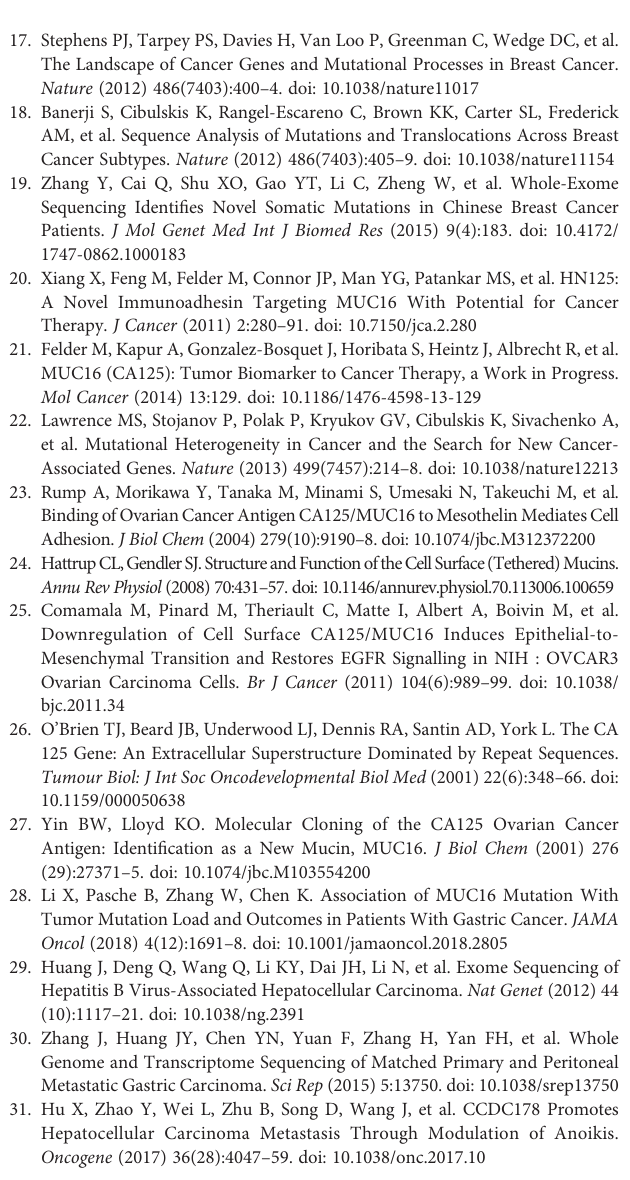
domains for CCDC178 in STAD with the labeled recurrent hotspots. (B) Box plot displaying the gene expression pro fi le across tumor samples and paired